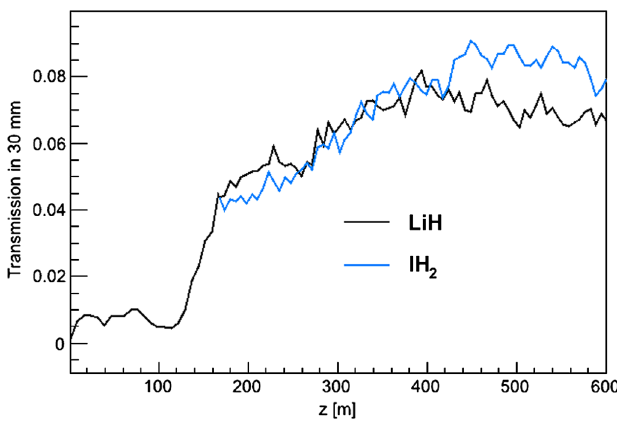
8. Simulated good muon yield of (cid:1) þ with capture opti- mized for higher energy and a cooling cell length of 3 m as opposed to 0.75 m in the baseline. The rf capture scheme was adjusted to capture at a central momentum of 273 MeV =c rather than the nominal 214 MeV =c of the baseline lattice. Two ab- sorber materials were simulated, lithium hydride (LiH) and liquid hydrogen ( lH 2